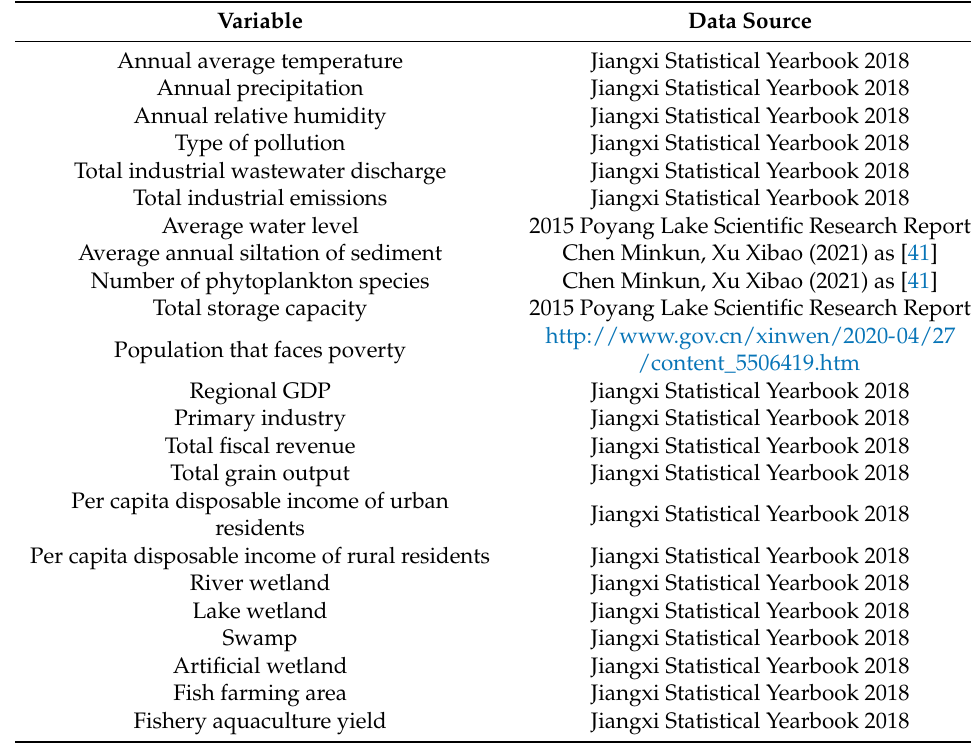
Table A1. Sources of data in the